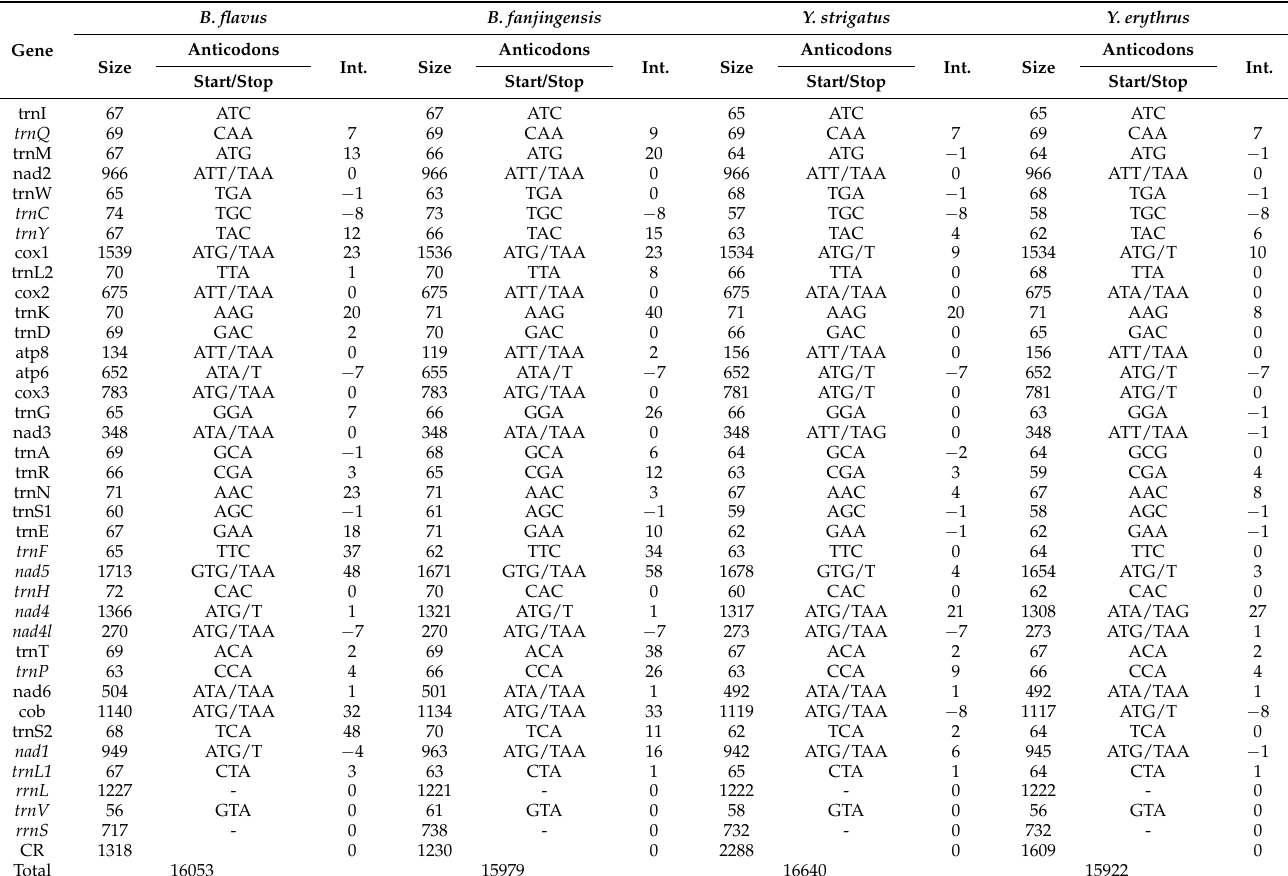
Table 1. List of total size and intergenic nucleotides for mitochondrial genes of B. flavus, B. fanjingensis, Y. strigatus , and Y. erythrus , with lengths of genes, anticodons of tRNAs, and start/stop codons of protein-coding genes. B. flavus B. fanjingensis Y. strigatus Y. Gene